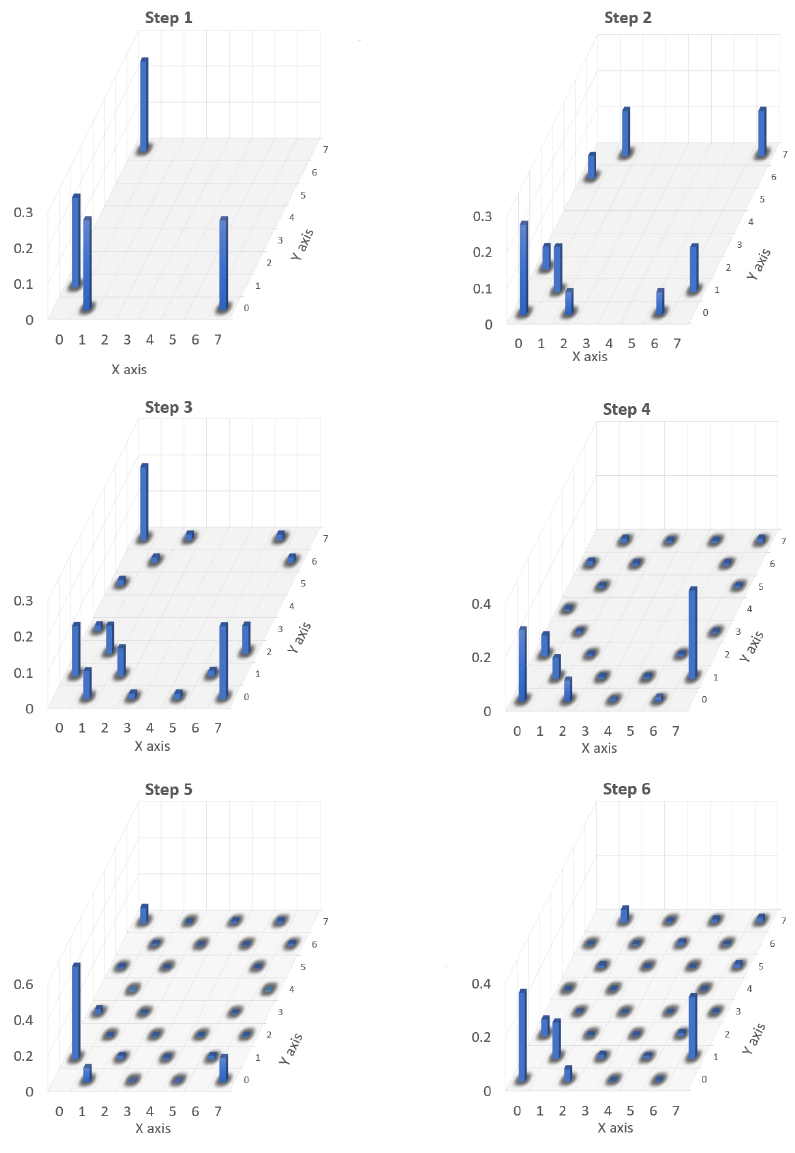
Figure 14. Probability representation of oriented QDRW moves on a